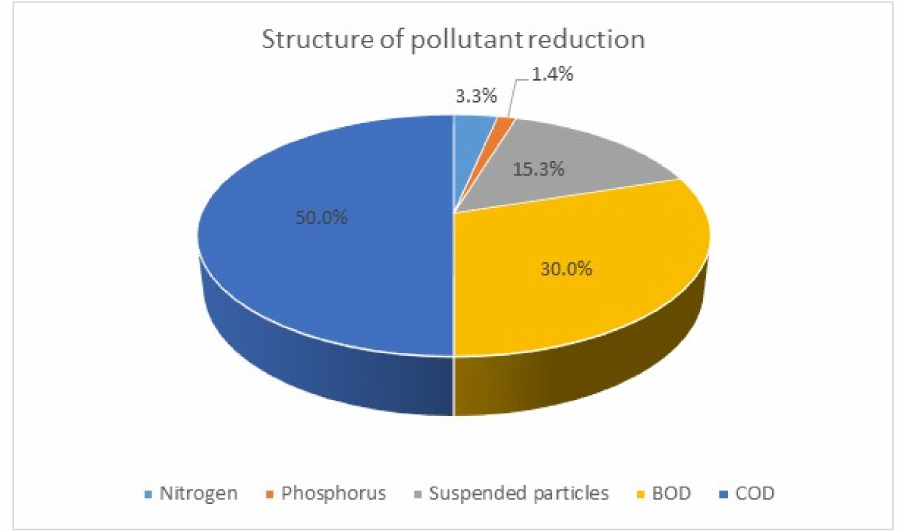
Figure 3. Structure of pollutant reduction after treatment in WWTP.